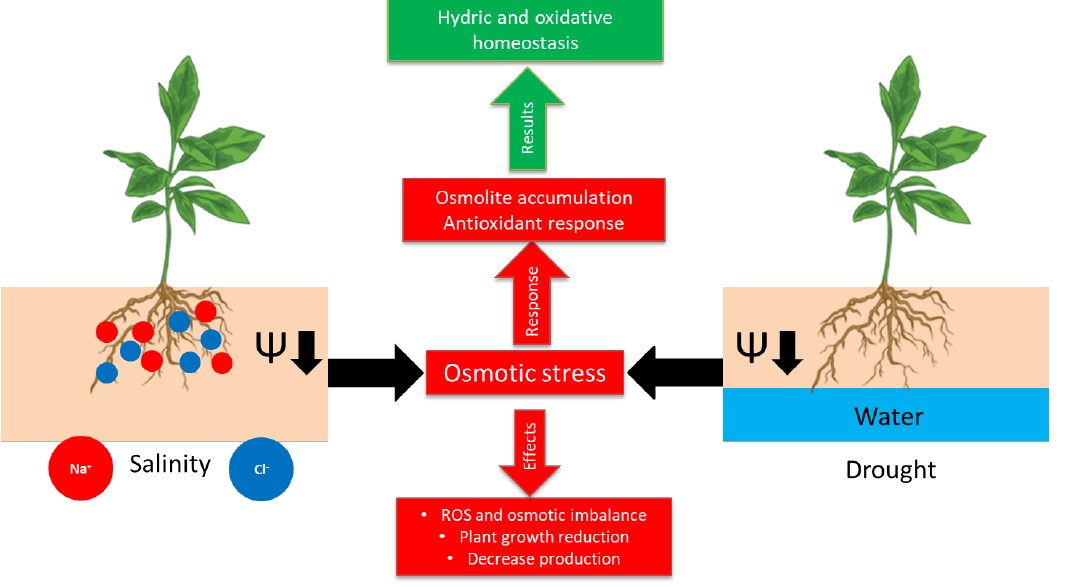
Figure 1. Schematic model of osmotic stress.